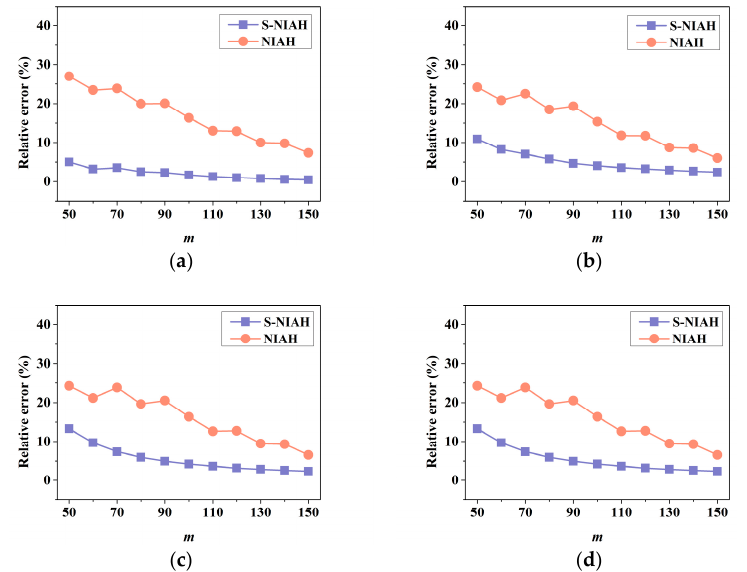
Figure 15. Relative error with respect to m under different methods ( a ) BCC; ( b ) BCCZ; ( c ) FCC; ( d ) FCCZ.